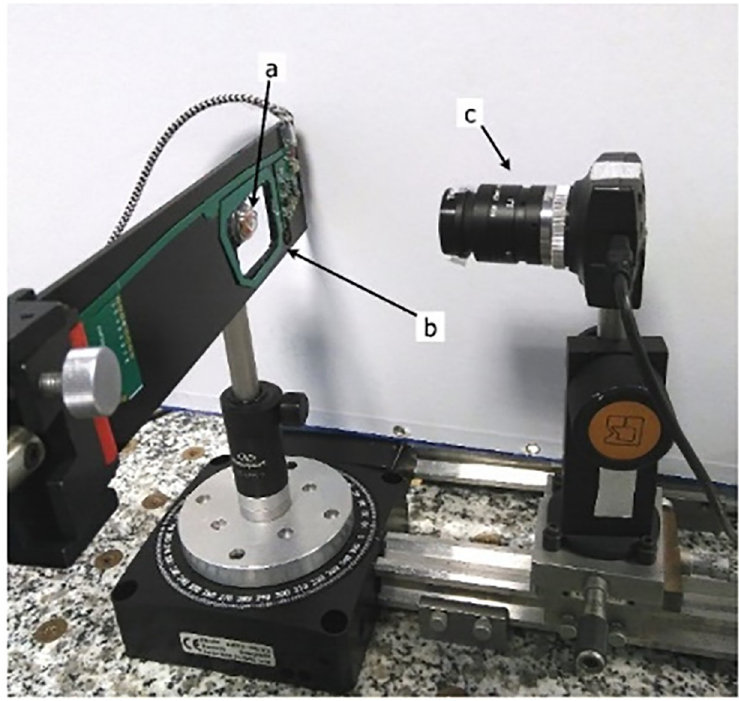
Fig 6. Camera characterization bench. a) CLP on the mock-up eye, b) primary antenna. c) CMOS